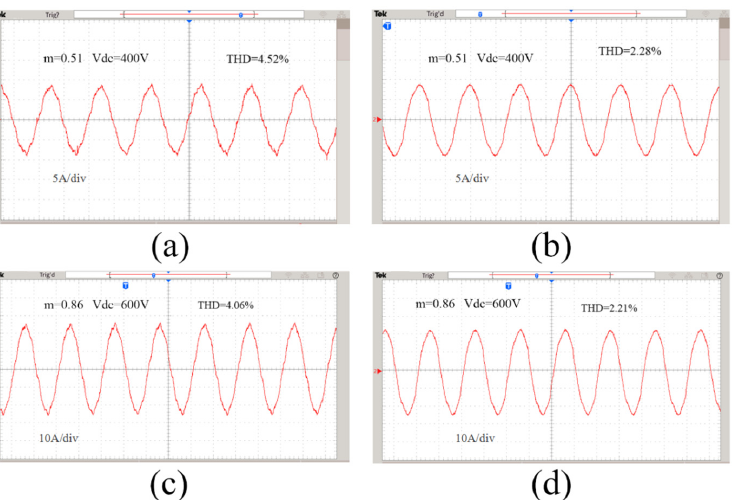
Figure 15. Input current experimental waveforms: ( a ) traditional method, m = 0.51, Vdc = 400 V; ( b ) proposed method, m = 0.51, Vdc = 400 V; ( c ) traditional method, m = 0.86, Vdc = 600 V; ( d ) proposed method, m = 0.86, Vdc = 600 V.